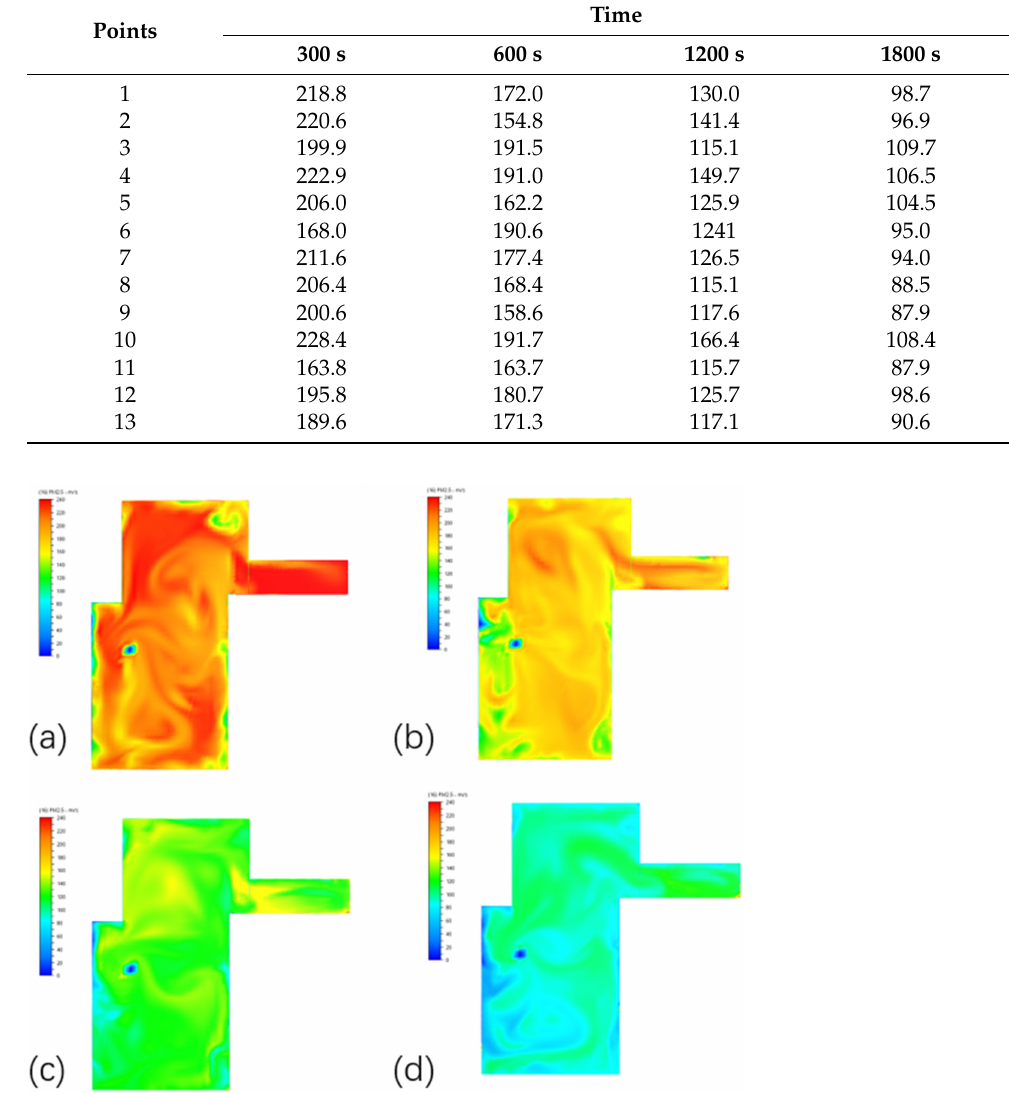
Table A3. Quantitative results of case 3.